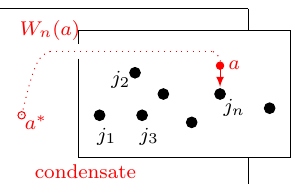
Figure 1 . There are N anyons labeled by the simple objects j n in C . There is also a vacuum — a reservoir that maintains an indefinite number of condensate anyons (simple direct summands a of A ). The creation operator W n ( a ) creates a dual of a -anyon (can be viewed as a hole of a -anyon) in the reservoir and inserts an a anyon to j n